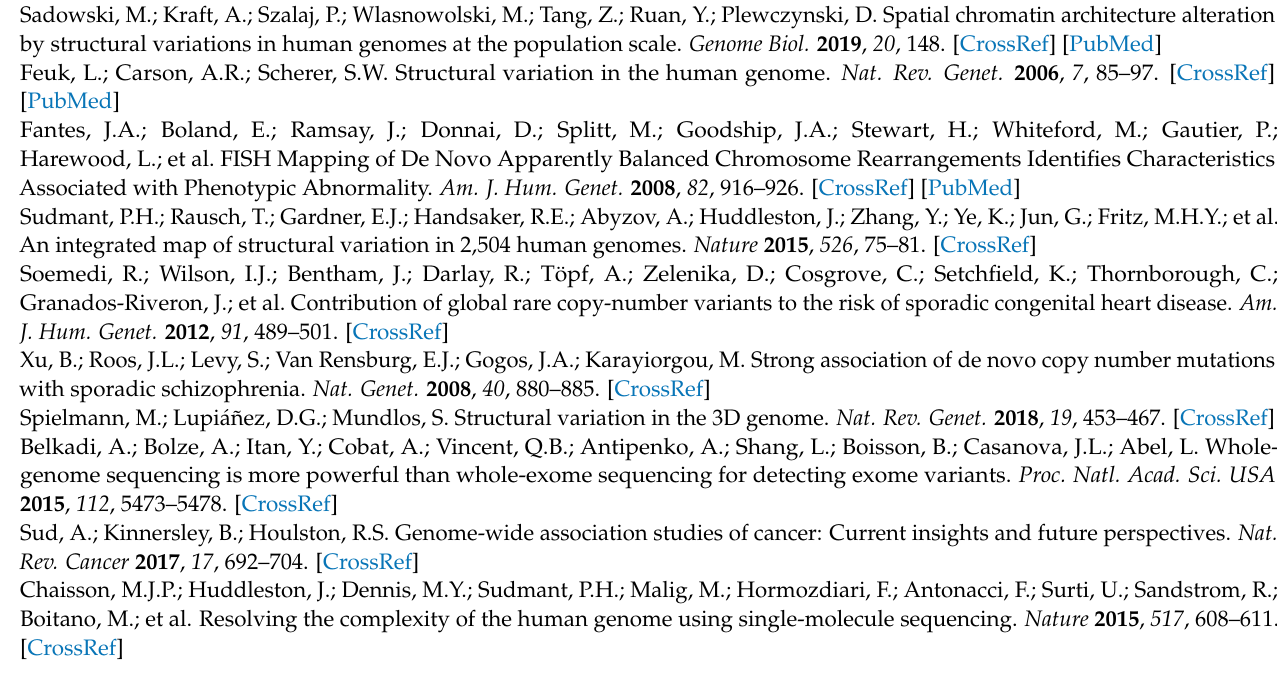
K562 cell line. Figure S2: Differential Rearrangements at the chromosomal level in THP-1 cell line. Figure S3: Translocations identified in K562 cell line. Figure S4: K562 translocations result from comparison between tools. Figure S5: Breakpoints identified in THP-1 Hi-C data. Figure S6: THP-1 translocations results from comparison between tools. Figure S7: Mate-pairs analysis of A562 WGS data. Figure S8: Mate-pairs analysis of K562 WGS data. Figure S9: Mate-pairs analysis of THP-1 WGS data. Figure S10: PCR-Amplification of K562 breakpoint region. Table S1: Hi-C Trans Result in A549. Table S2: hic_breakfinder in A459 Cell line. Table S3: HiNT-TL in A459 Cell line. Table S4: PCR primer designed for translocation